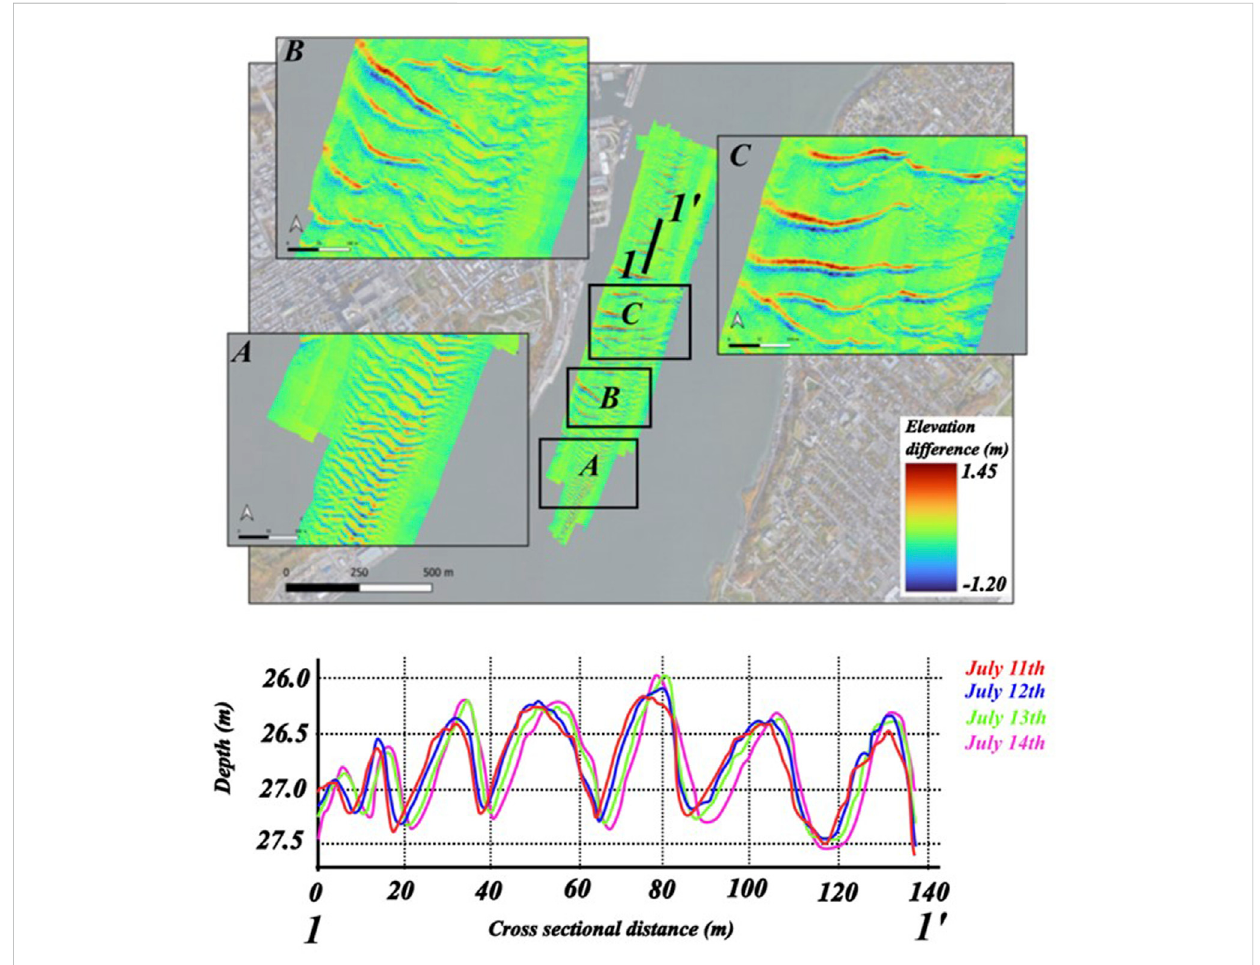
FIGURE 9 Differences in depth between the fi rst and fourth day of the July 2022 with close-ups in (A – C) campaign and a cross sectional pro fi le through the fi eld of dunes showing their displacement throughout the 4 days.